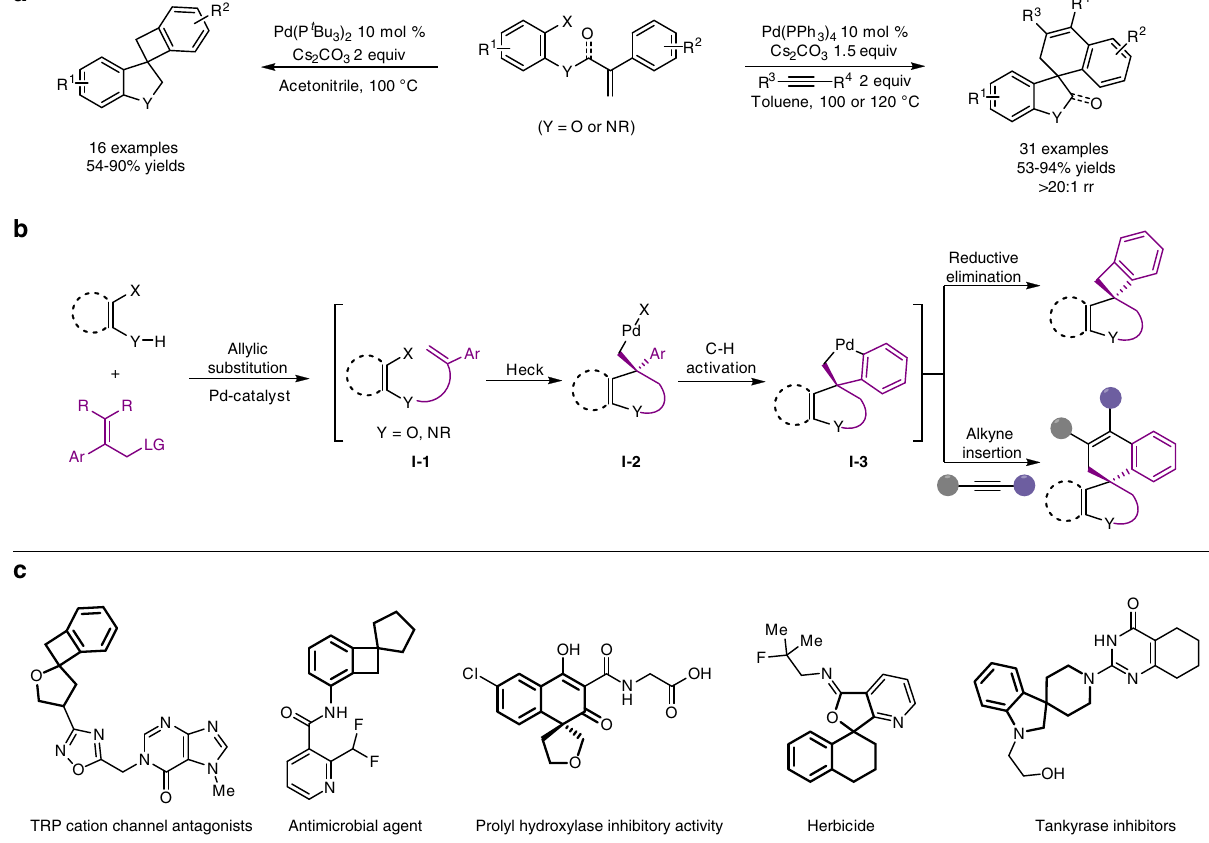
Fig. 1 Concepts. a Previous work: palladium-catalyzed intramolecular cyclization for the synthesis of spiroheterocycles. b This work: palladium-catalyzed allylic substitution/Heck/C – H activation(/alkyne) cascade processes. c Selected examples of related bio-active spiro